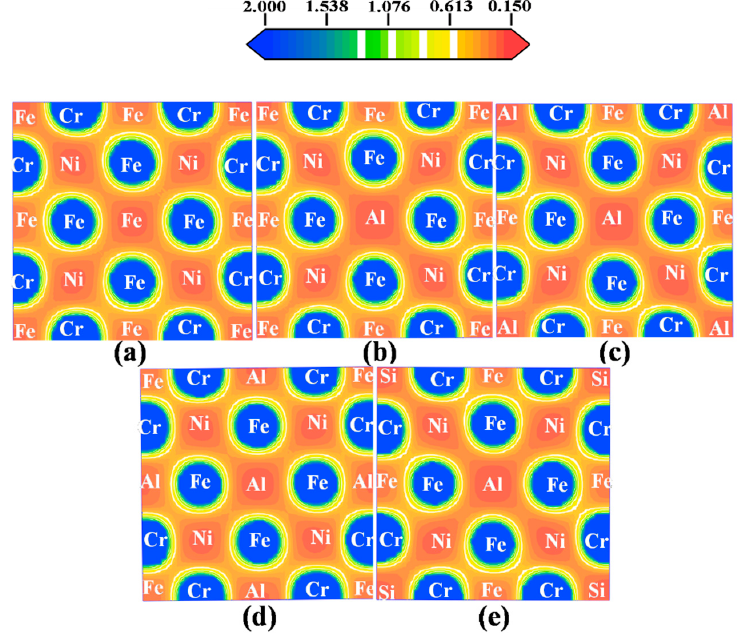
Figure 9. Charge density distribution maps of di ff erent systems in the (002) plane: ( a ) Fe 8 Cr 4 Ni 4 ; ( b ) Fe 7 Cr 4 Ni 4 Al; ( c ) Fe 6 Cr 4 Ni 4 Al 2 ; ( d ) Fe 5 Cr 4 Ni 4 Al 3 ; ( e ) Fe 6 Cr 4 Ni 4 AlSi.